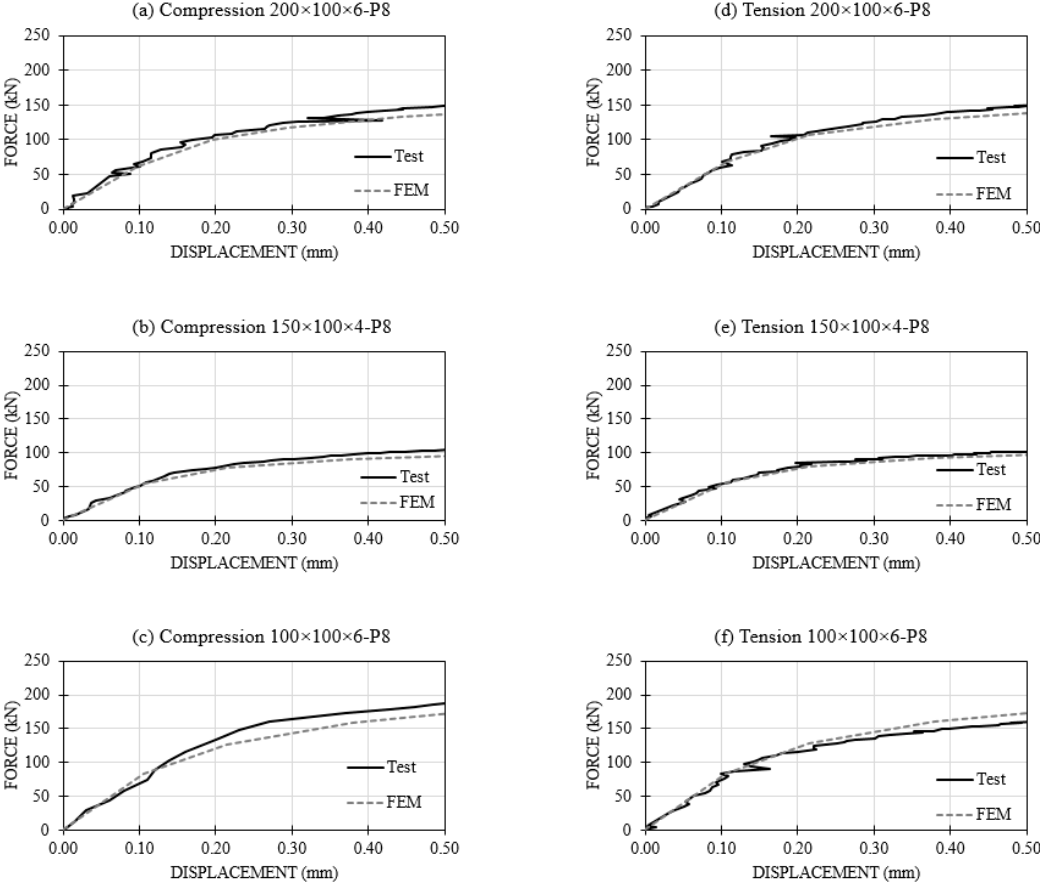
Figure 10. Test vs. FEM in load-displacement curve. ( a ) Compression 200 × 100 × 6-P8; ( b ) Compression 150 × 100 × 4-P8; ( c ) Compression 100 × 100 × 6-P8; ( d ) Tension 200 × 100 × 6-P8; ( e ) Tension 150 × 100 × 4-P8; ( f ) Tension 100 × 100 × 6-P8.